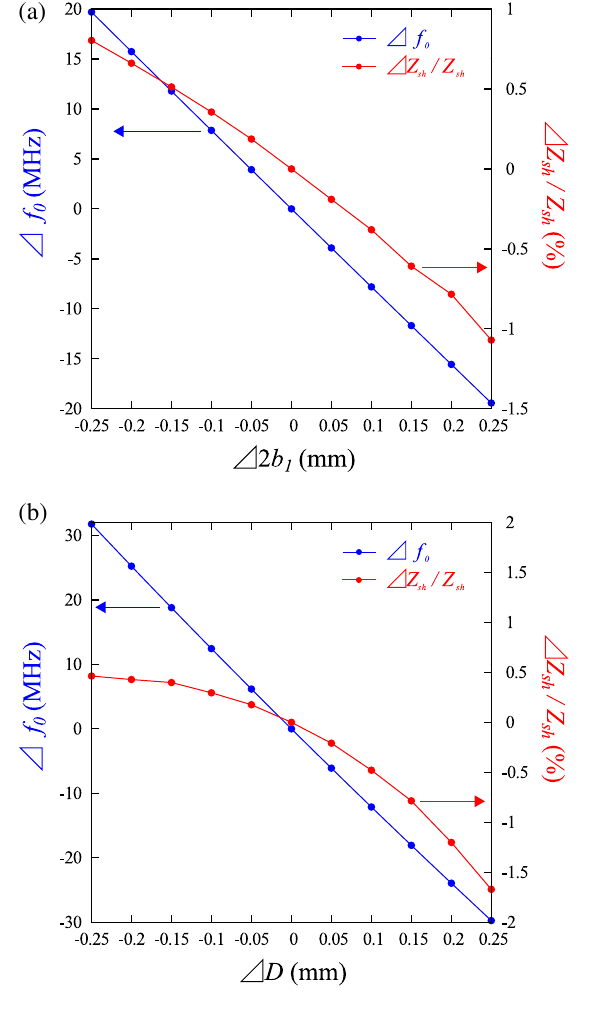
=Z on (a) the deviation sh sh